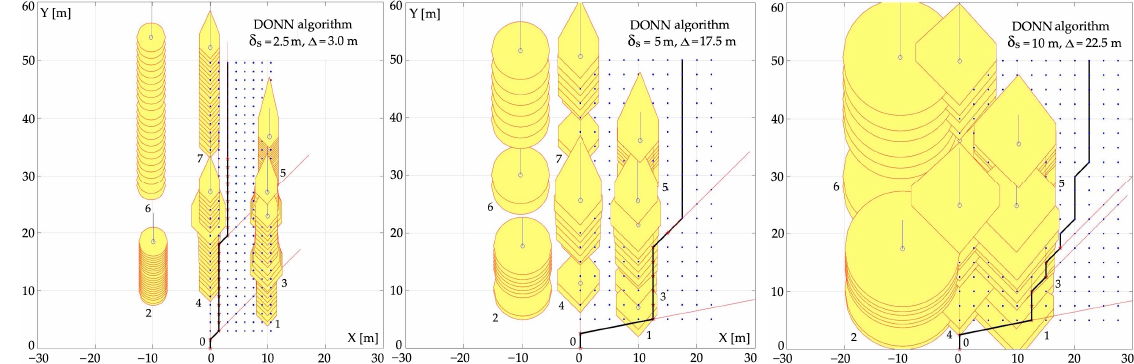
Figure 13. Safe dynamic trajectory of our autonomous vehicle in one-way traffic while passing seven other autonomous vehicles for three safe passing distance values.